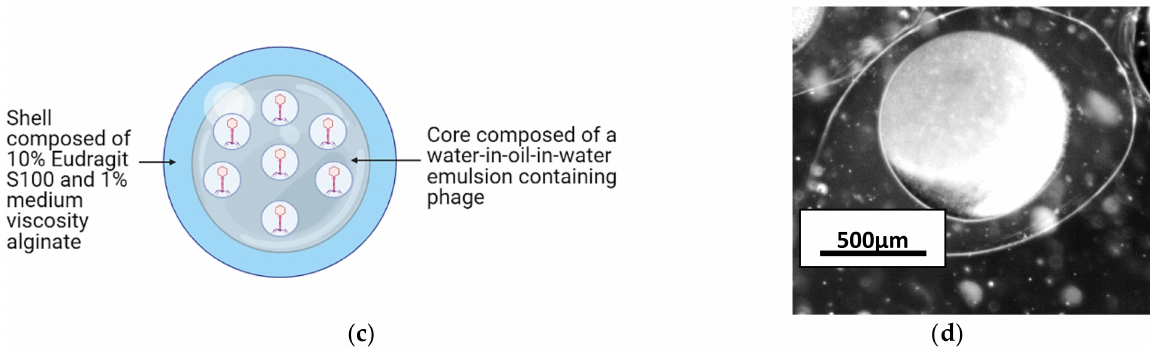
Figure 1. Schematic representation of the core-shell capsule production process using the Buchi encapsulator. ( a ) The ‘core’ syringe contained an emulsion composed of T3 phages, Miglyol +5% ( v / v ) polyglycerol polyricinoleate (PGPR) and was set to a flow rate 3 × lower than the shell syringe. The ‘shell’ syringe contained a solution of 10% ( w / v ) S100 and 1% ( w / v ) medium viscosity alginate or a solution of 1% ( w / v ) alginate only. An outer (shell) and an inner (core) nozzle were used, sealed with a rubber gasket and the vibration unit (magnet) was placed above the nozzle head. The frequency and electrode parameters were set and maintained at a constant setting before the syringe pumps were started. The capsules were collected in a beaker located beneath the nozzle containing 1 M CaCl 2 with gentle agitation using a magnetic stirrer bar at 100 RPM. ( b ) Representation of the laminar jet production process by which the nozzle forms a droplet within the shell nozzle jet. ( c ) Schematic diagram of the core-shell capsules including the phage contained in a water-in-oil emulsion and S100/alginate outer shell. ( d ) Optical image of the capsules before alginate crosslinking and polymer protonation. The water-in-oil core was surrounded by an S100/ alginate shell, captured using a × 10 magnification lens. Created with